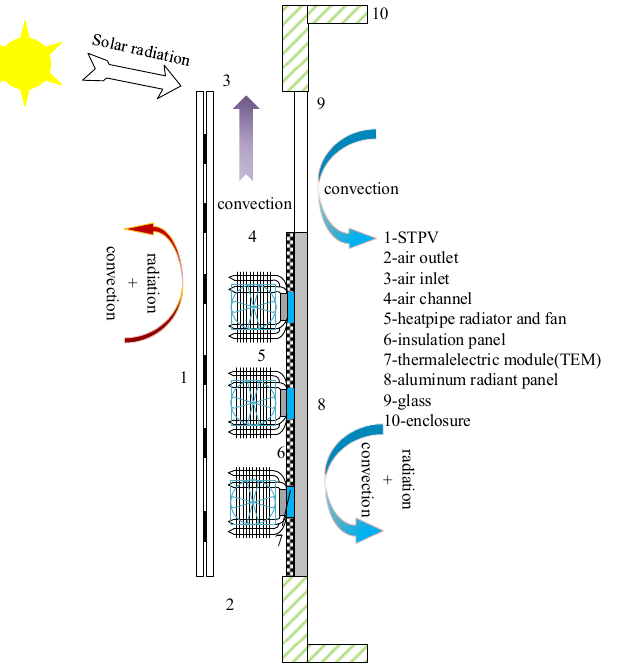
Figure 1. Structure of PV-TEC radiant window. The translucent thermoelectric radiant panel structure shields a portion of the solar radiation passing through the translucent photovoltaic module. The thermoelectric module (TEM) connected to the back of the metal aluminum plate absorbs heat from the panel. Thus, the surface temperature can be kept lower than the ambient temperature. The outdoor air passes through the air channel sandwich between the PV panel and the envelope to carry away the heat from the hot end of the TEM. Heat sinks are installed at the hot end of the TEM to increase the efficiency of heat dissipation by expanding the area for heat exchange. The thermal barrier is attached between the metal aluminum plate and the heat sink to prevent heat transfer between the two that could lead to degradation of the system’s performance. DC fans are installed above the heat sink and air channel respectively to change the airflow rate on the heat exchange surface, thus enhancing the heat dissipation performance at the hot end. The schematic structure of the whole device is shown in Figure 1.